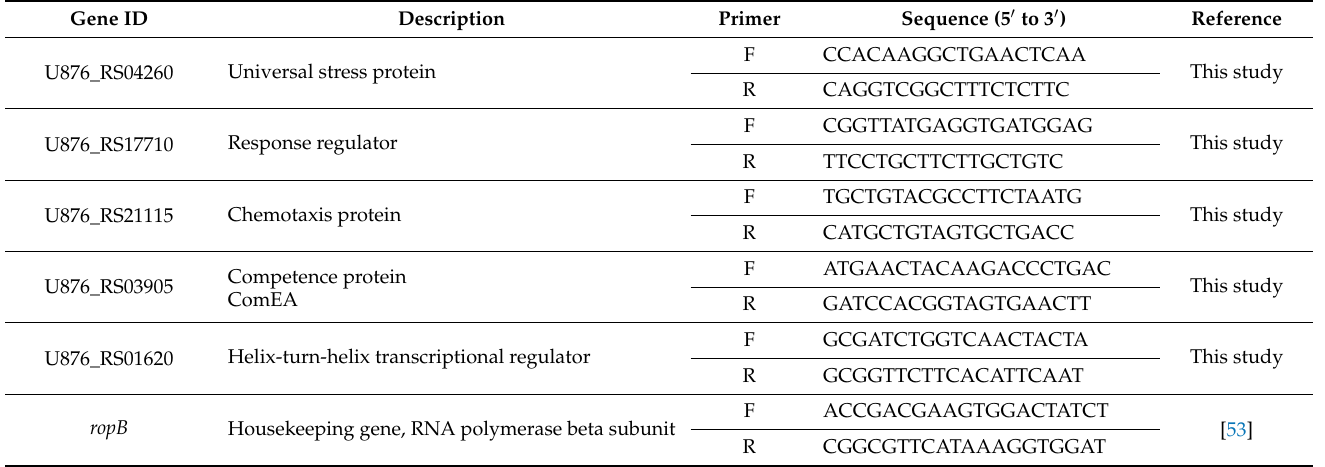
Table 2. Primers used in